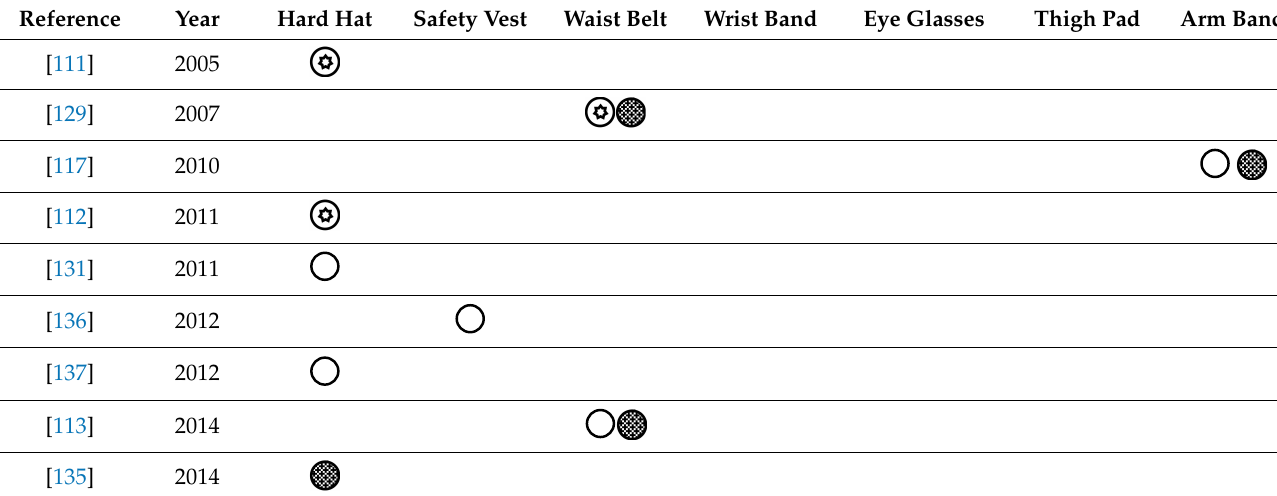
Table 3. The review criteria resulted in 29 unique research papers. A majority of these papers utilized auditory alarms (19), followed by tactile feedback Hard hat, with eleven instances, was the most frequent on-body placement. The studies conveying information beyond a binary presence or absence of hazard are recognized with a star mark - , , and , for auditory, visual, and tactile communication, respectively.